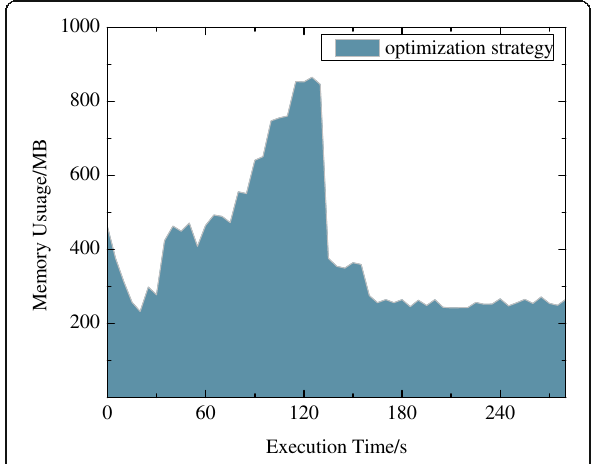
Fig. 4 The memory utilization of TerSort